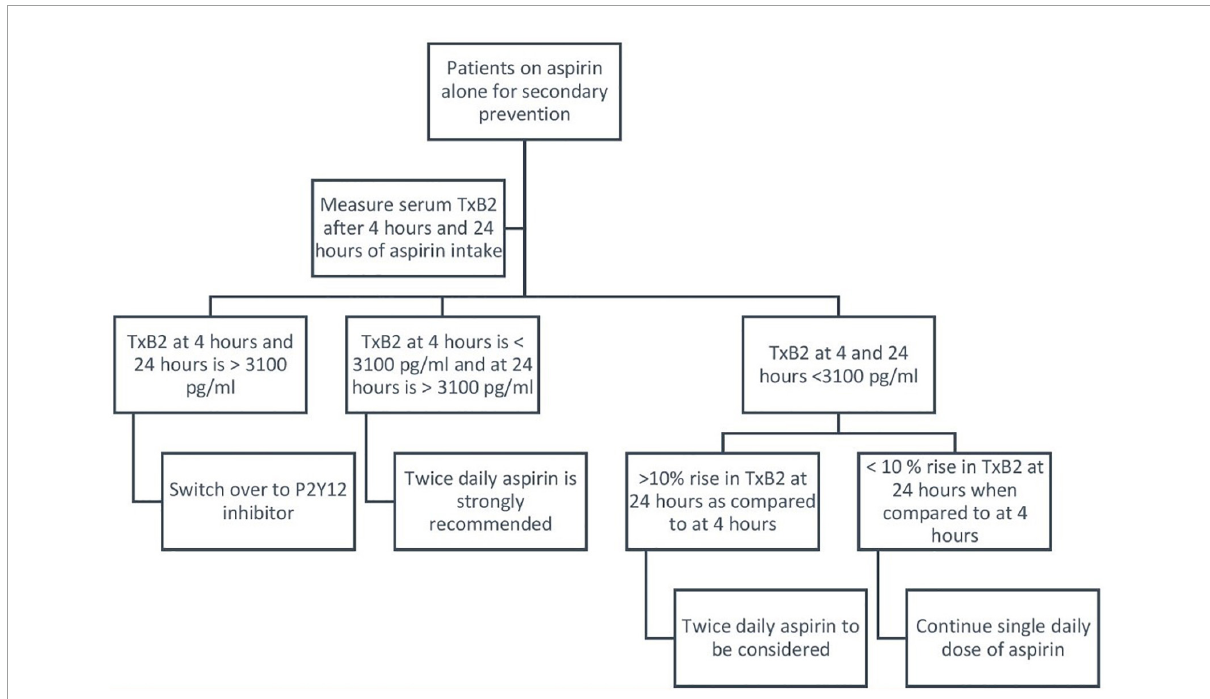
FIGURE2 Suggested algorithm for personalized allocation of acetylsalicylic acid for secondary prevention of coronary artery disease. Abbreviation: TxB2, thromboxane